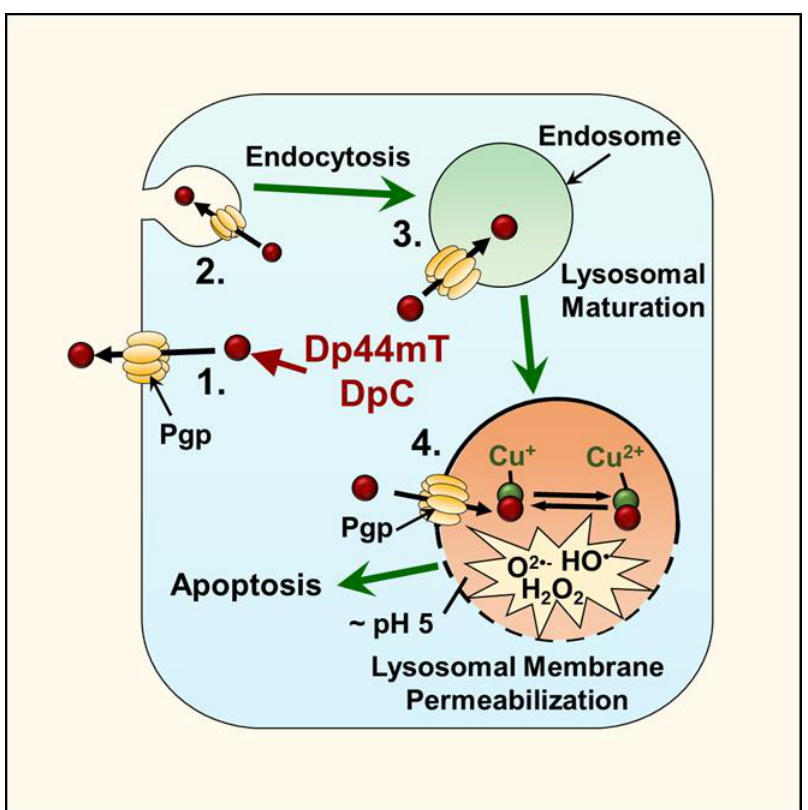
Figure 6. Thiosemicarbazone lysosomal transport and ROS production. Both Dp44mT and DpC use the Pgp transporter to enhance their transport into lysosomes. The expression of Pgp is present on the plasma membrane, and also on endosomal and lysosomal membranes. Plasma membrane endocytosis results in the internalization of Pgp and its presence within endosomes and lysosomes, with this process resulting in the Pgp transporter pumping substrates, such as DpC and Dp44mT, into the lumen of the endosome or lysosome. Upon the entrance of these ligands into the lysosome, their ability to bind the iron and copper derived from the breakdown of intracellular constituents leads to the generation of redox active complexes that induce lysosomal membrane permeabilization and